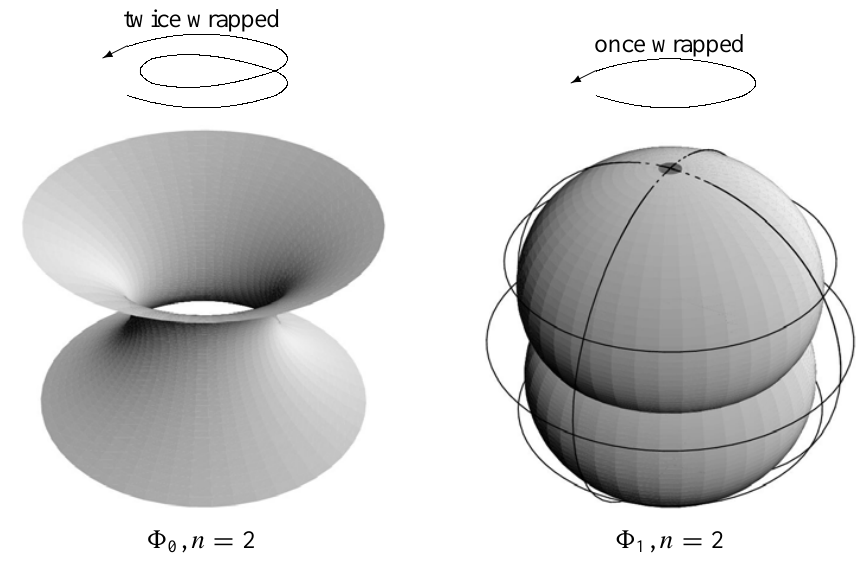
Fig. 2 – The surfaces (cid:2) 0 and (cid:2) 1 in (iii) of Remark